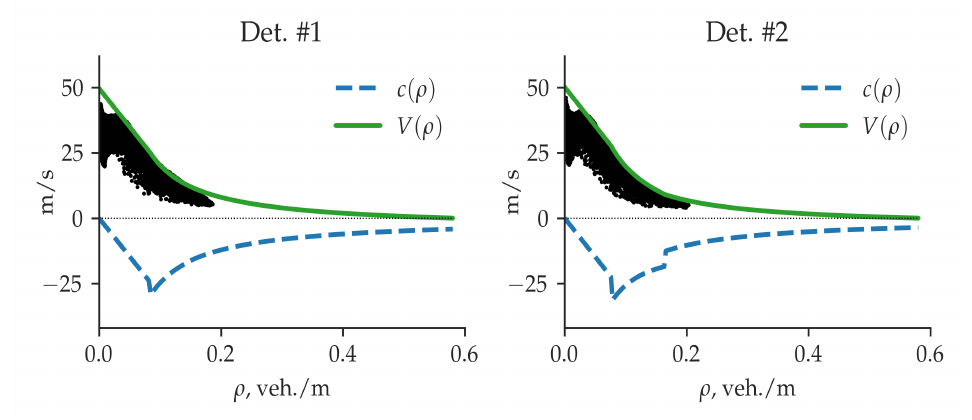
Figure 4. Equilibrium speed V ( ρ ) (solid green line) and relative velocity of the congestion propa- ( ρ ) gation c ( ρ ) = ρ ∂ V (dashed blue line) as functions of density aggregated over four lanes of I-580, ∂ρ together with the historic data for the one-year period. Left: detector #1, right: detector